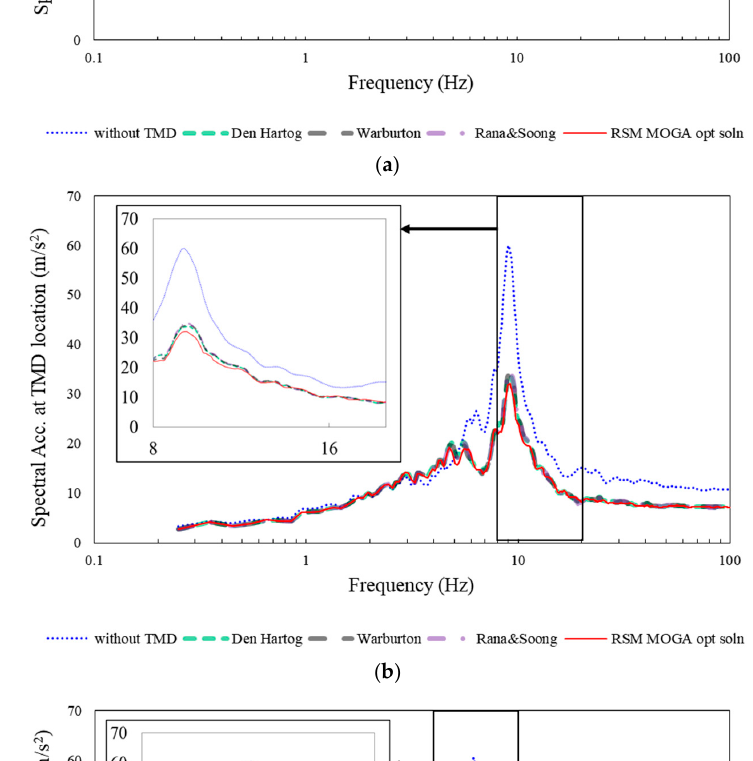
Figure 11. Comparison of the reaction forces at the lowest support of the piping system: ( a ) X direction; ( b ) Y direction; ( c ) Z direction; ( d ) total.